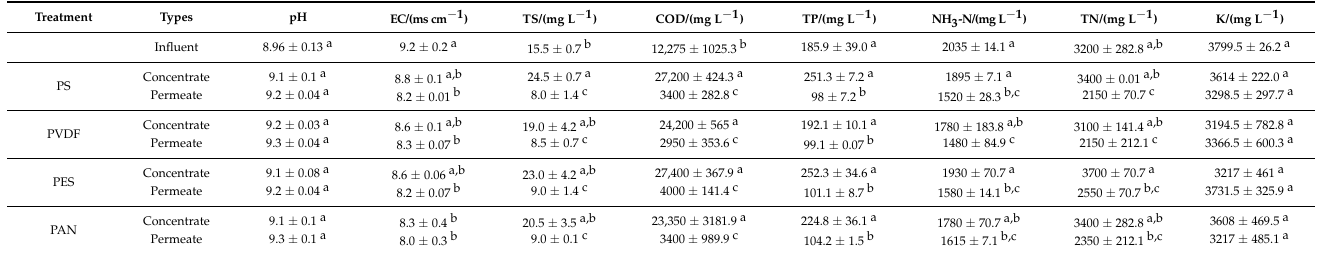
Table 5. Physicochemical characteristics of the influent, concentrates, and permeates.